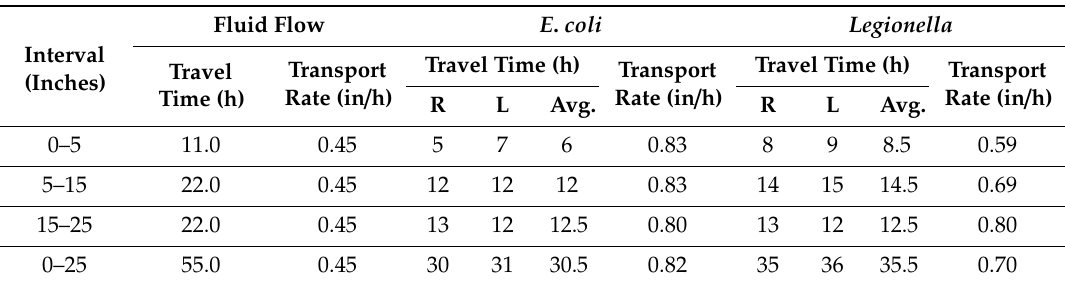
Table 4. Travel times for fluid vs. E . coli vs. Legionella